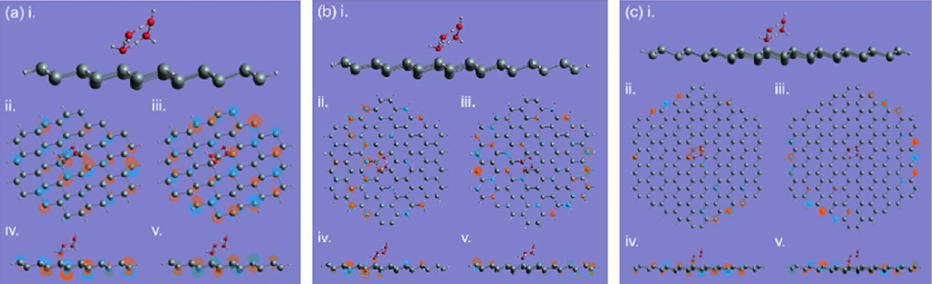
Figure 4. The square ice absorptions on the 3 × 3 , 4 × 4 , and 5 × 5 SND are shown in ( a – c ), respectively. In each sub-figure, (i) is the optimized structure, (ii) and (iii) ((iv) and (v)) are the top (side) views of HOMO and LUMO, respectively.